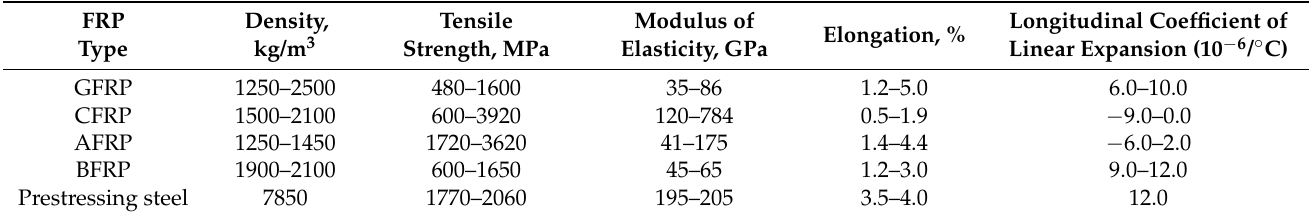
Table 1. Basic physical and mechanical properties of different FRP bars